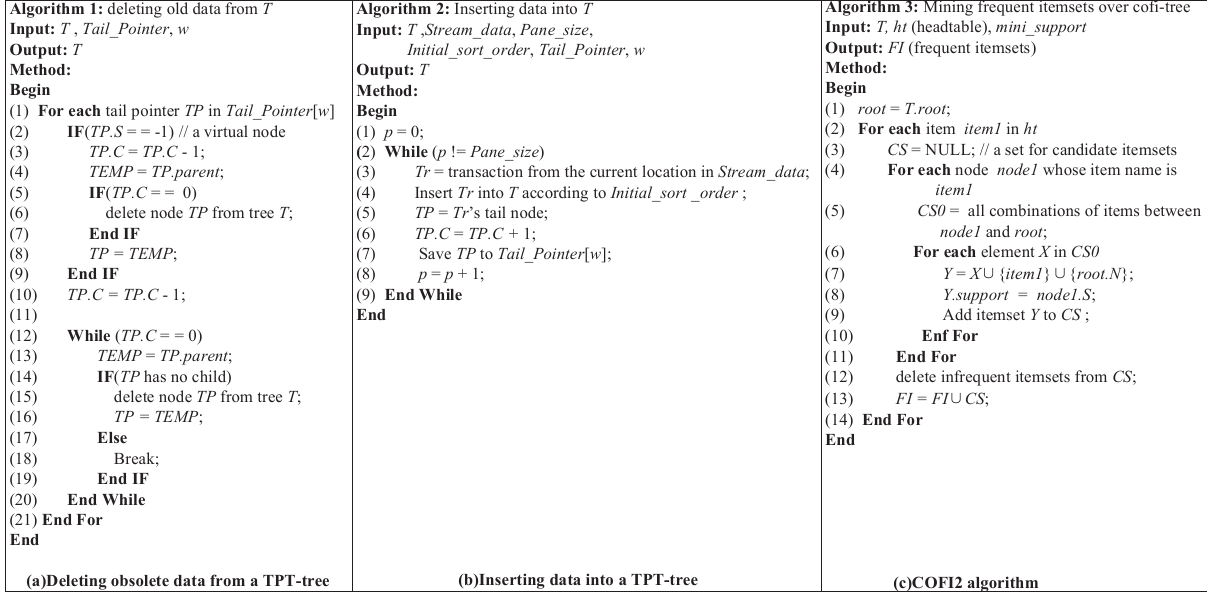
Algorithm 3: Mining frequent itemsets over cofi-tree Input: T, ht (headtable), mini_support